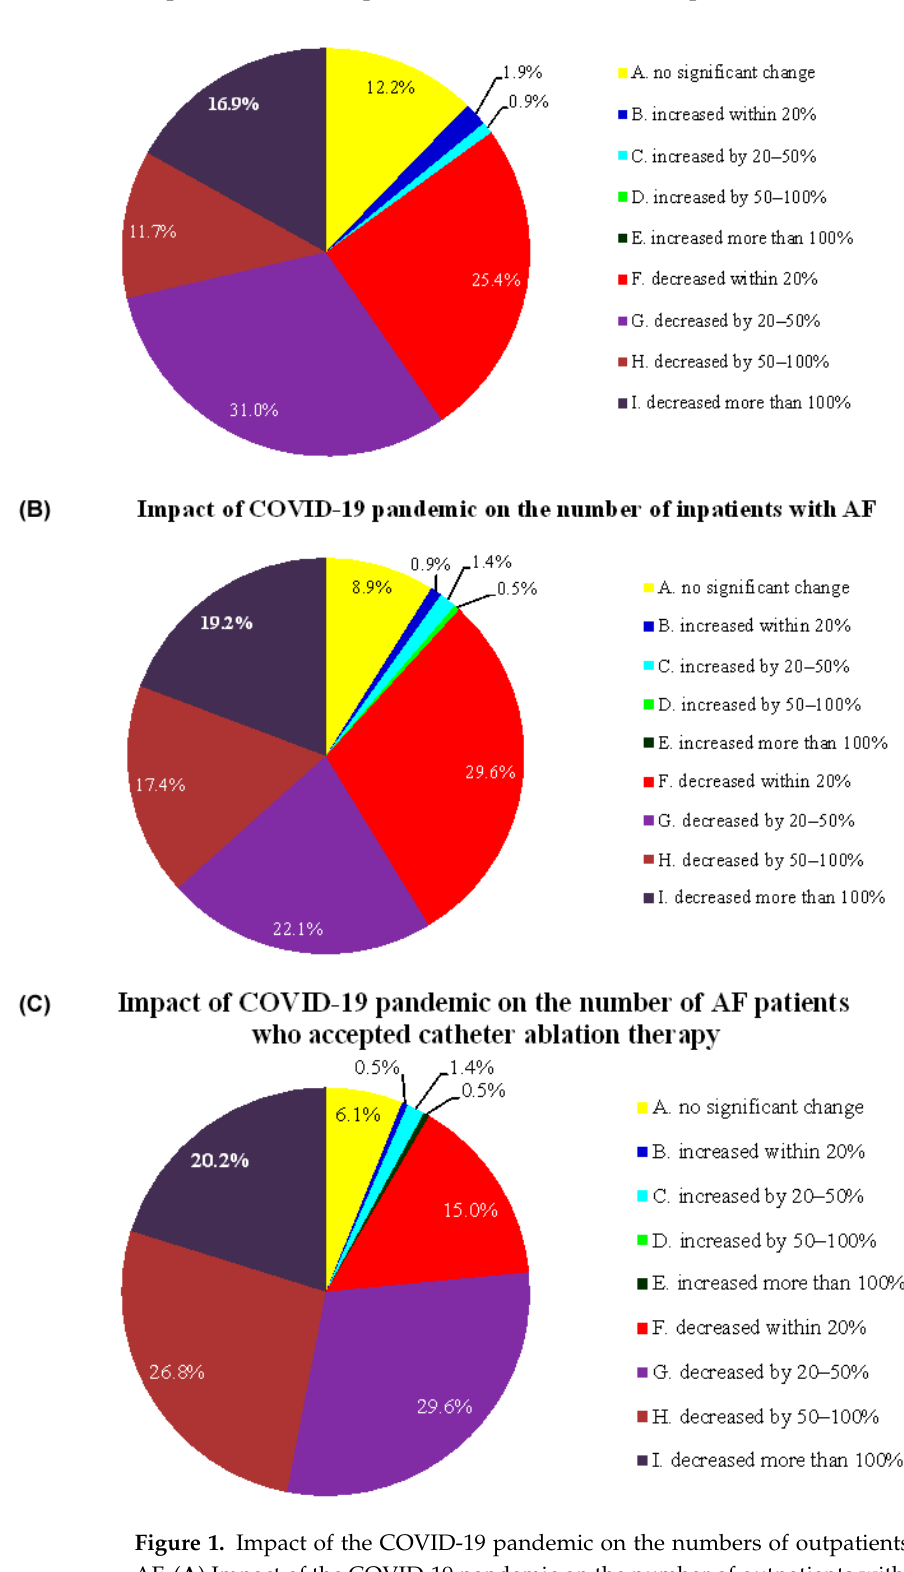
Figure 1. Impact of the COVID-19 pandemic on the numbers of outpatients and inpatients with AF. ( A ) Impact of the COVID-19 pandemic on the number of outpatients with AF. ( B ) Impact of the COVID-19 pandemic on the number of inpatients with AF. ( C ) Impact of the COVID-19 pandemic on the number of AF patients who underwent catheter ablation